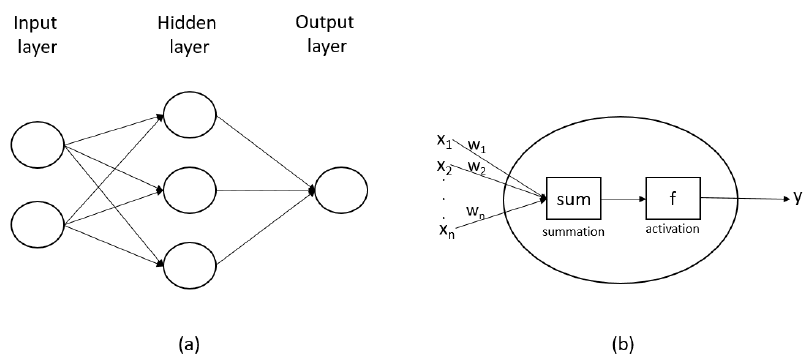
Figure 1. ( a ) A schematic of an artificial neural network (ANN); and ( b ) a schematic of a node.